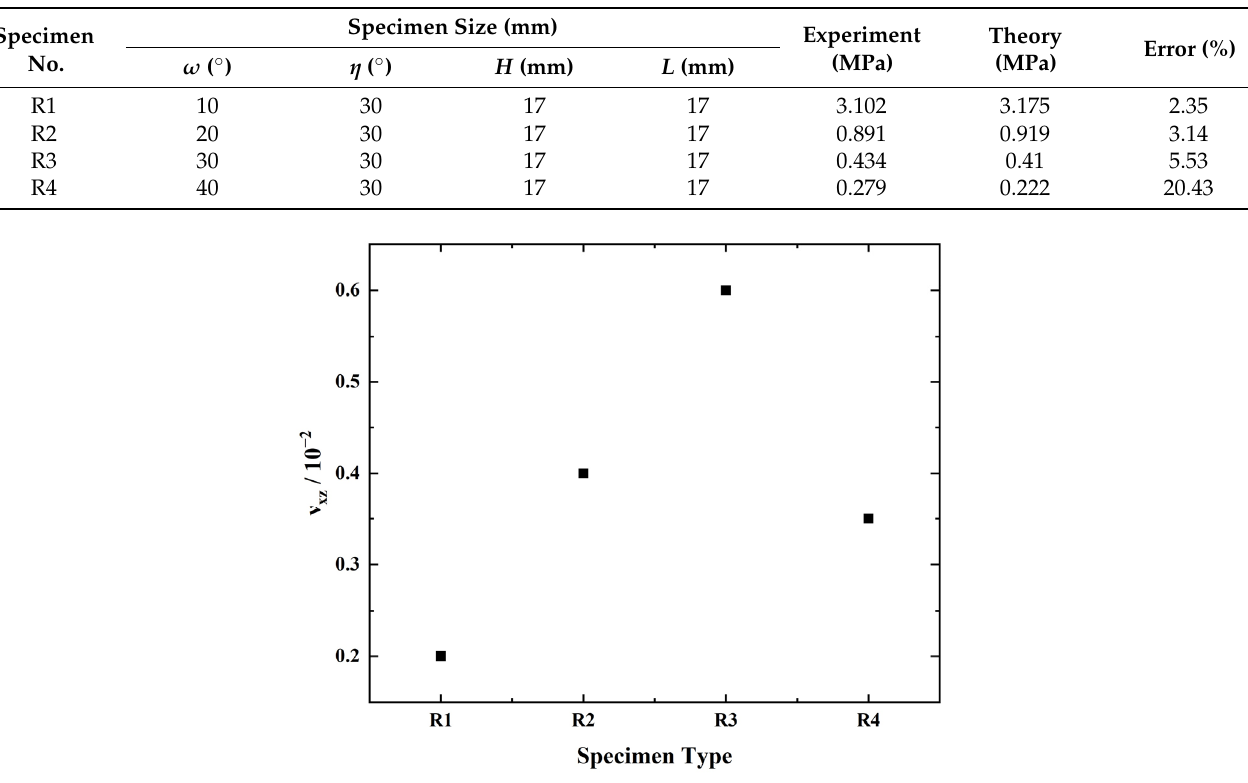
Table 2. Young’s modulus of 3D ZPR honeycomb.